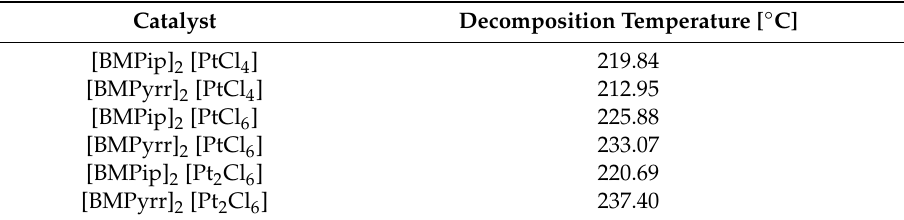
Table 2. Decomposition temperatures of the studied compounds at 10% of weight loss.